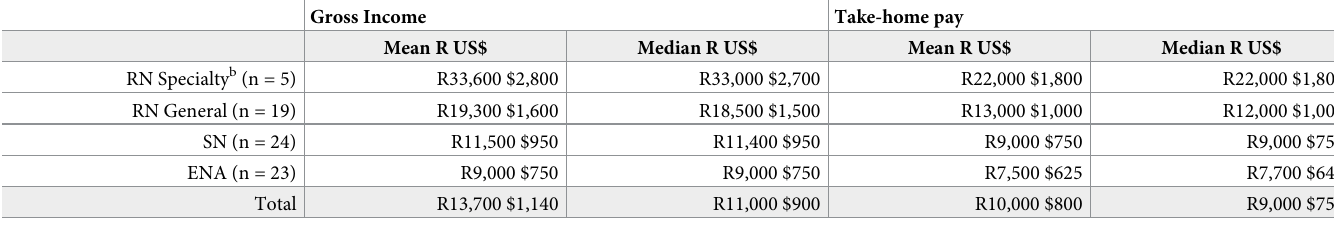
Table 5. Monthly income in rand, rounded to the nearest R500 (U.S. dollars at R12/$1) a .